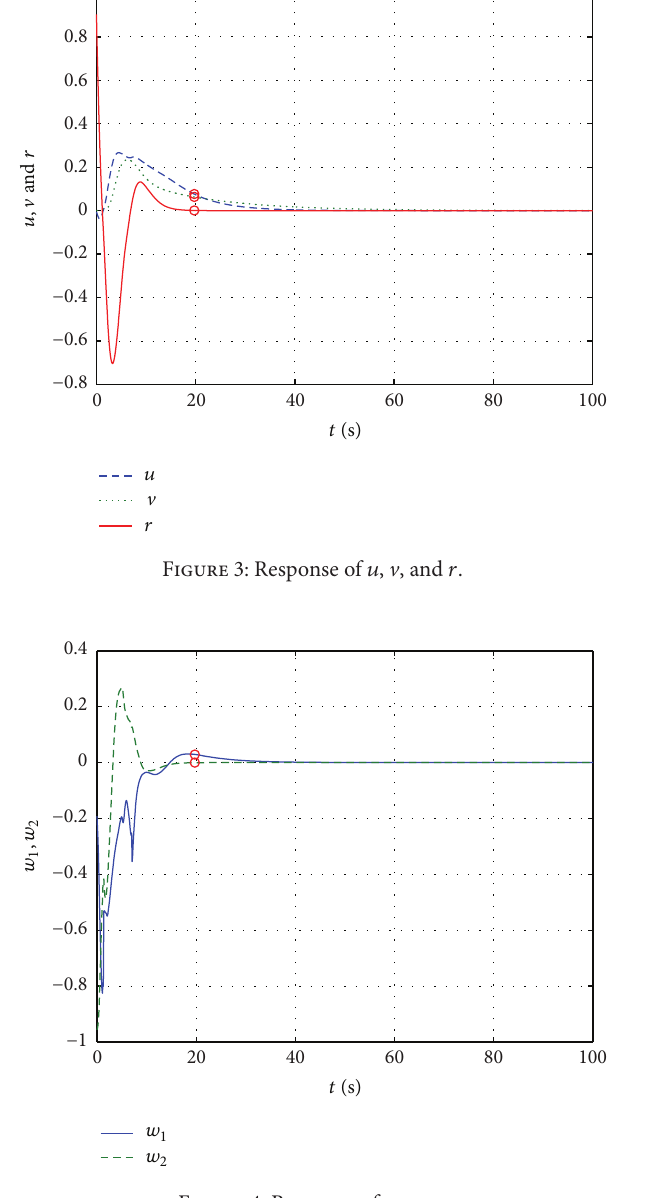
Figure 4: Response of 𝑤 1 , 𝑤 2 .